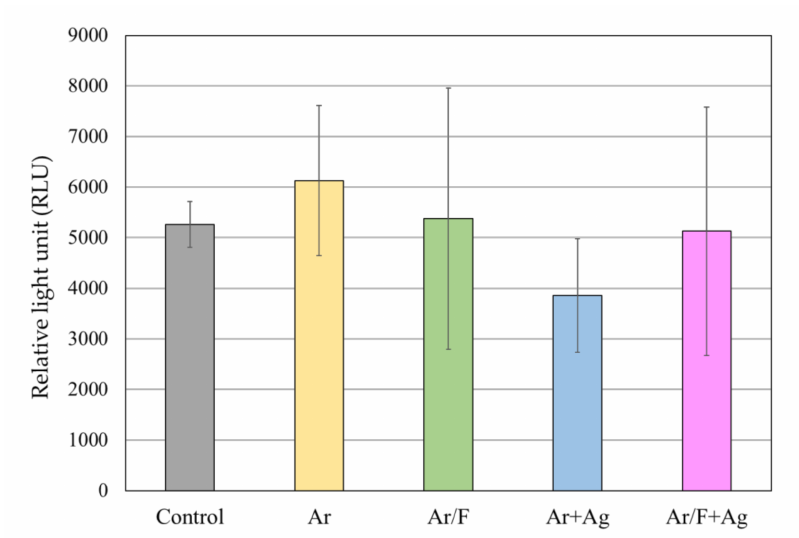
Figure 8. The luminescence intensity of the C. albicans suspension that was in contact with each specimen for four hours. There were no significant di ff erences (ANOVA / Tukey, α = 0.05).